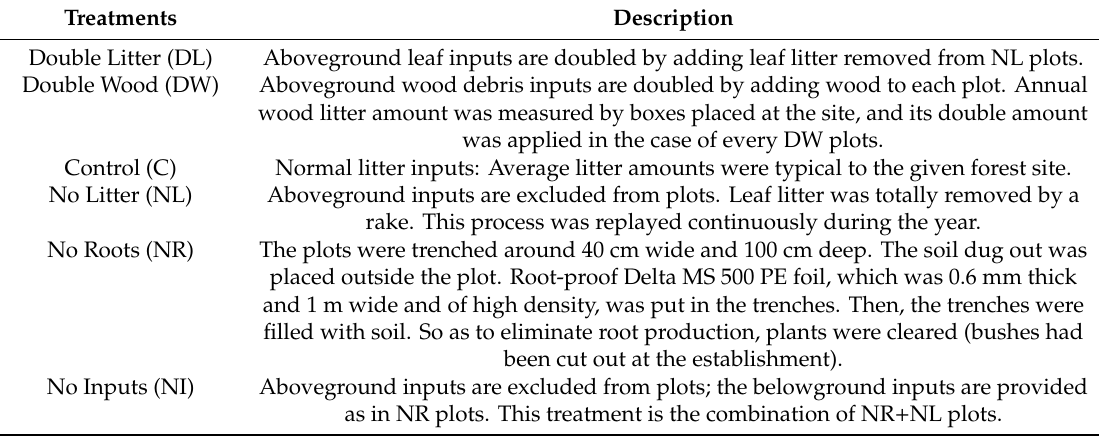
Table 1. The applied DIRT (Detritus Input and Removal Treatments) at S í kf˝ok ú t Project site (Hungary) as part of the ILTER (International Long-Term Experimental